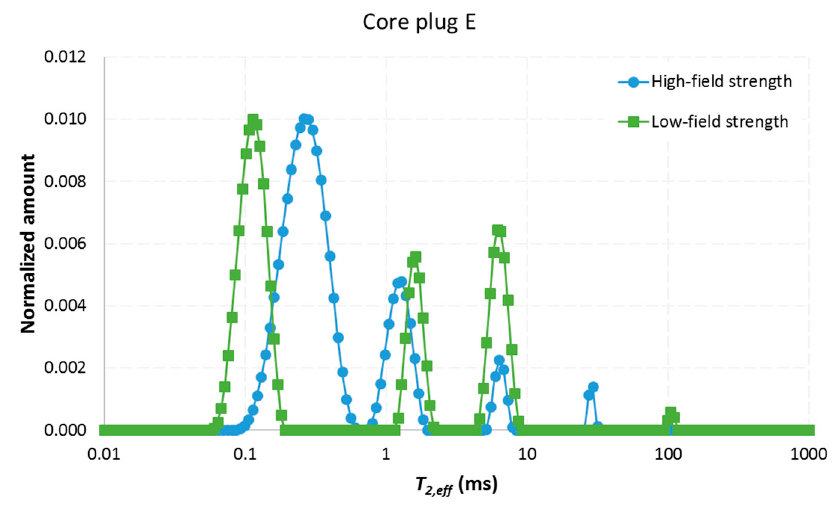
Figure 11. Transverse relaxation distribution for core plug E obtained by the CPMG sequence at high-field strength, B 0 = 4.70 T, and low-field strength, B 0 = 0.28 T. The low-field distribution is normalized with respect to the bulk water distribution, and the sum of the data points is a measure of the porosity of the core plug. The high-field distribution is scaled to the amplitude of the low-field distribution.